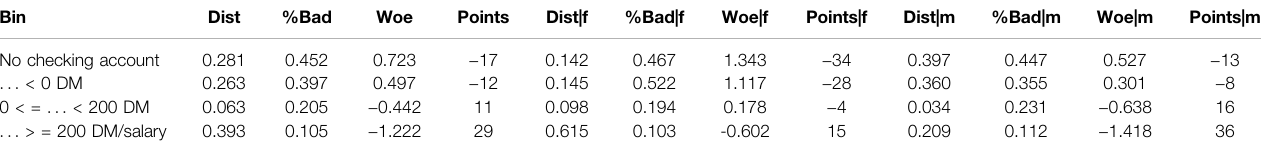
The solid lines indicate performance on the test data for the traditional (blue) and the fair model (green). The traditional model is